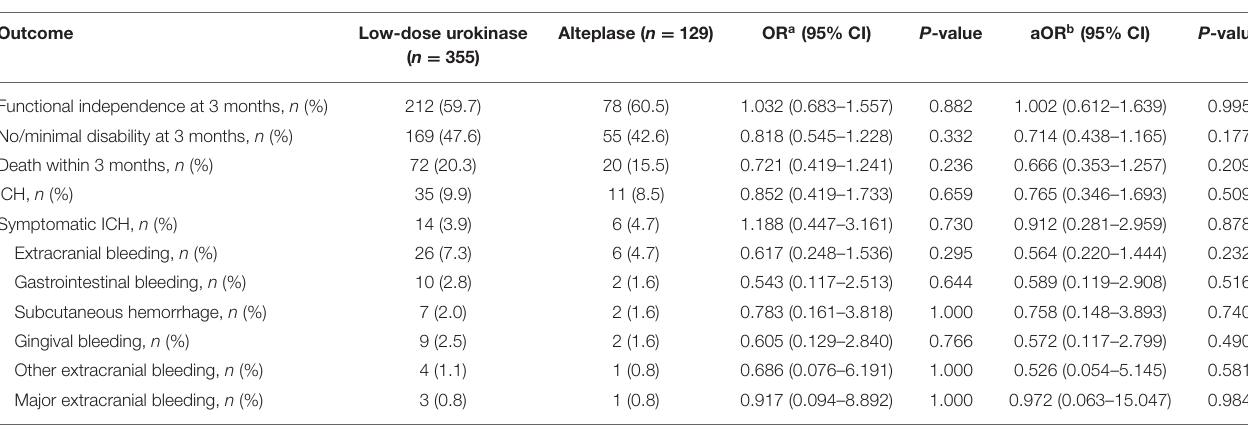
TABLE 4 | Subgroup analysis of low-dose urokinase and alteplase.